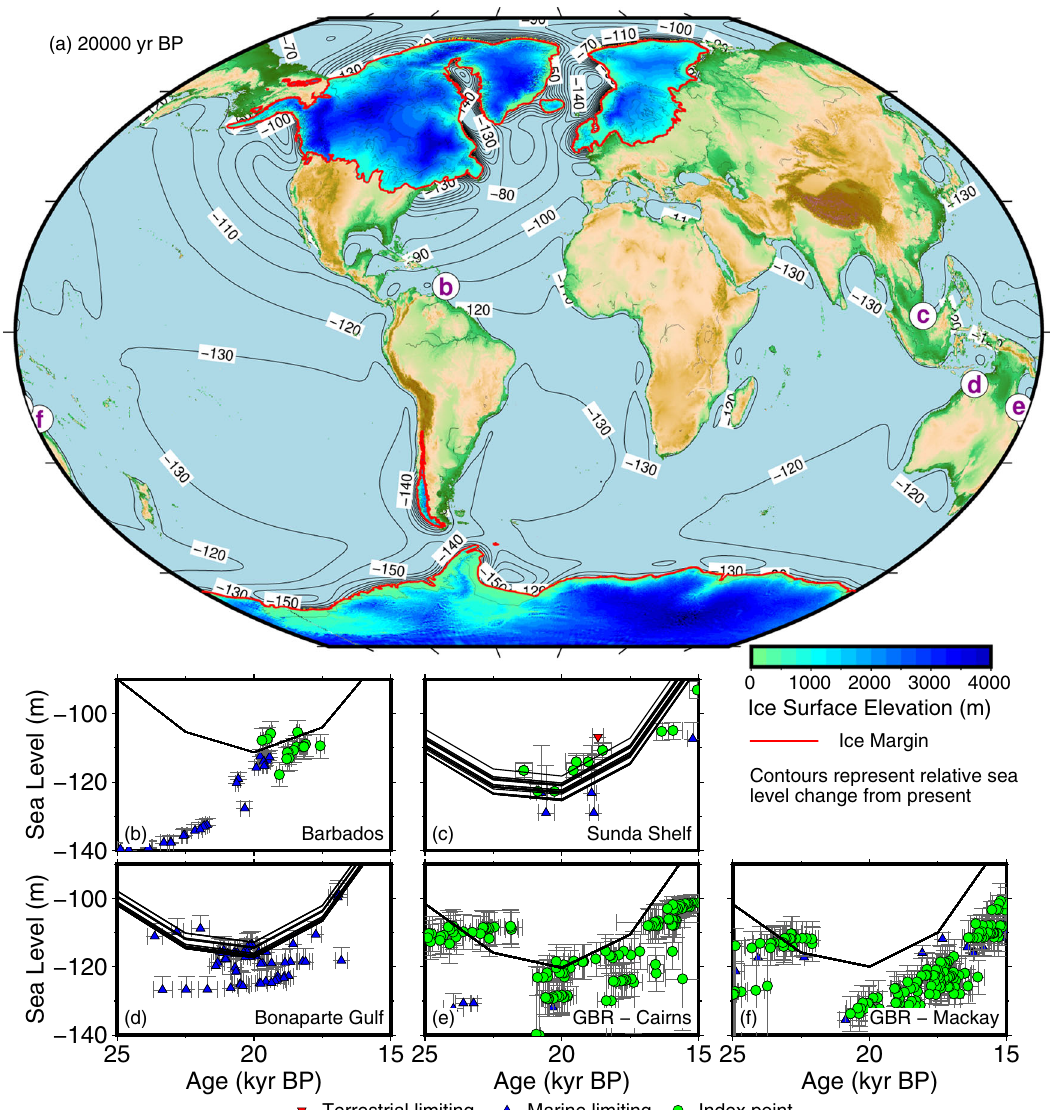
Fig. 3 Last Glacial Maximum (LGM) ice sheets, paleotopography, and far- fi eld sea level. a Paleotopography reconstruction at 20,000yr BP, with contours indicating calculated relative sea level compared to present. Sea level at b Barbados 102 , c Sunda Shelf 103,104 , d Bonaparte Gulf 105 , e Great Barrier Reef east of Cairns 106 , and f Great Barrier Reef east of Mackay 106 . Multiple calculated sea-level curves on the plots (black lines) are due to the fact that the samples come from a broad geographical region, and there is regional variation in relative sea level. We calculate sea level at the location of each sample. The sea-level indicators include index points (sea level is near or at the elevation of the sample), terrestrial limiting (sea level should be below the elevation of the sample), and marine limiting (sea level should be above the elevation of the sample). Error bars represent 2 σ uncertainty in age, and uncertainty in measured elevation and geological context for sea